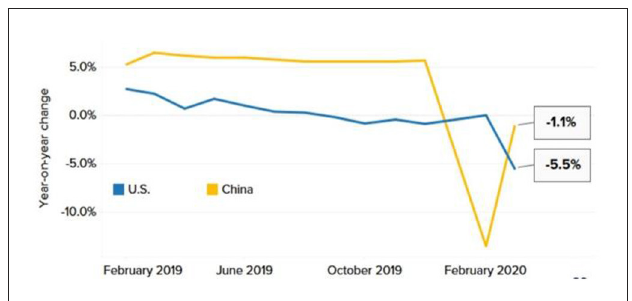
FIGURE10 Coronavirus impact on factory output. Source: U.S. Federal Reserve, National Bureau of Statistics of China, Refinitiv.